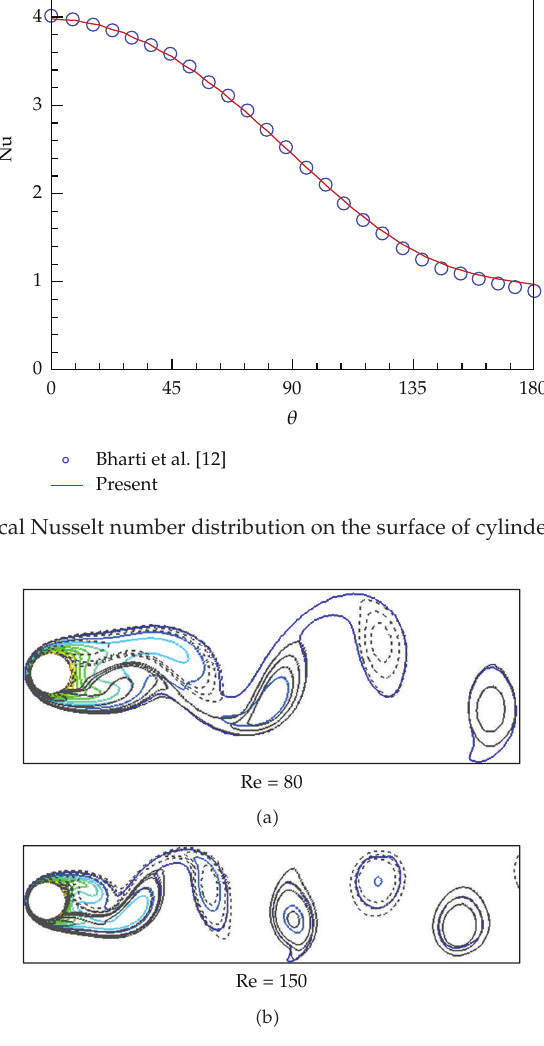
Figure 3: Instantaneous isotherms (cid:2) colorful (cid:3) and vorticity contours (cid:2) gray (cid:3) for unsteady forced convection from a stationary